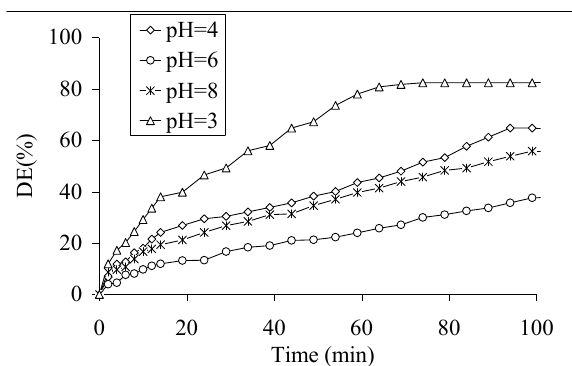
Fig. 2: Effet of solution pH on NBB oxidation (C Figure 2: Effet of solution pH on NBB oxidation ( C i =30mg/L, [H 2 O 2 ]=0.005m M, catalyst mass=0.05g)